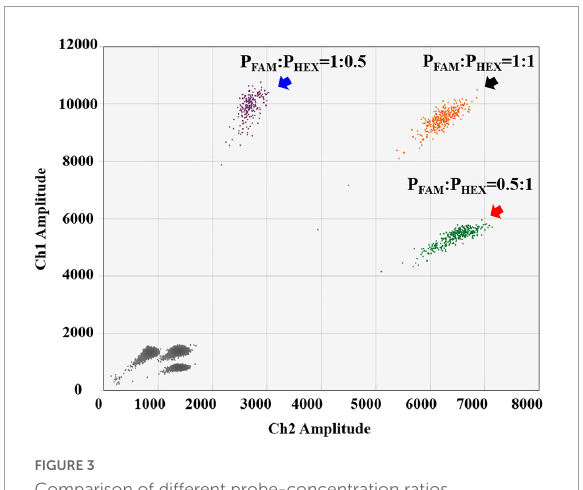
FIGURE3 Comparison of different probe-concentration ratios (FAM-labeled and HEX-labeled probes) for the detection of B. anthracis .